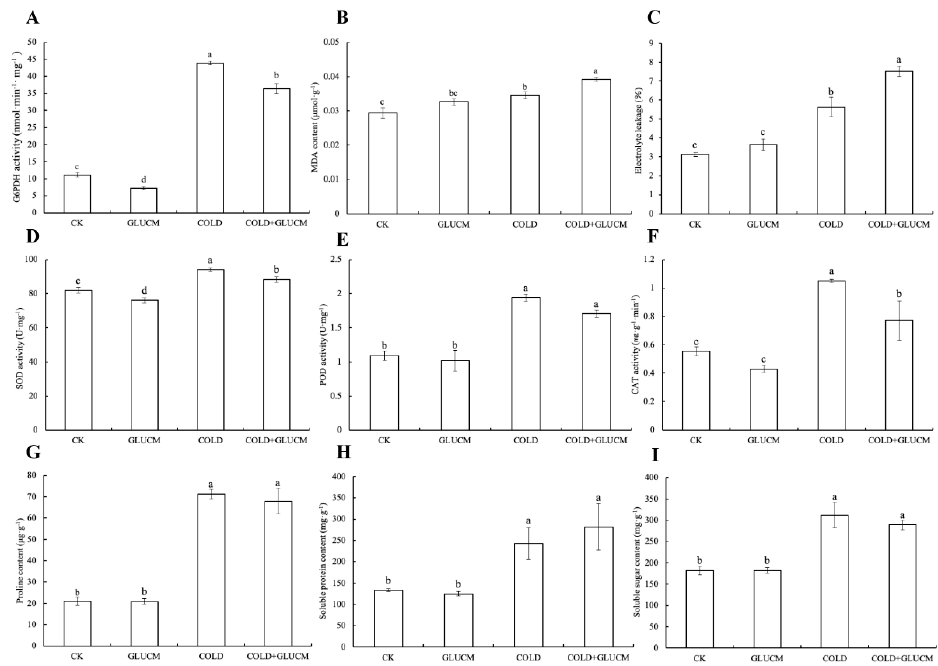
Figure 3. E ff ect of FaG6PDH enzyme activity on related physiological indexes in response to cold stress. Potted strawberry plantlets respectively treated by distilled water and glucosamine were subjected to room temperature and 0 ◦ C environment for 24 h. Leaves were collected to measure G6PDH activity ( A ), and other related physiological indexes ( B – I ). Di ff erent lowercase letters indicate significant di ff erences at p <